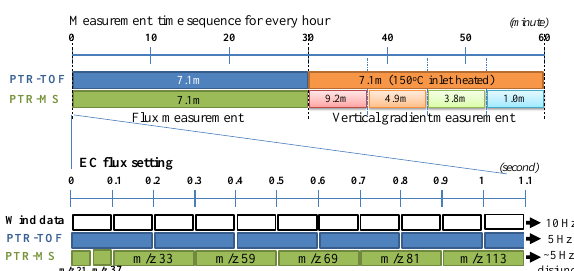
Fig. 2. Data acquisition sequence for the PTR-TOF-MS, PTR-MS, and 3-D sonic anemometer. The upper panel shows the hourly measurement scheme. The lower panel describes the data collecting sequence of one cycle corresponding to 1.1 seconds, which was repeated for first 30 minutes of each hour to measure fluxes. Data from the sonic anemometer and PTR-TOF-MS were collected at 10 Hz and 5Hz, respectively. PTR-MS flux data ( m/z 33, 59, 69, 81 and 113) were sampled with dwell times of 0.2 seconds (overall 5Hz disjunct) after collecting the primary ion signal ( m/z 21 and 37) for the first 0.1 seconds.